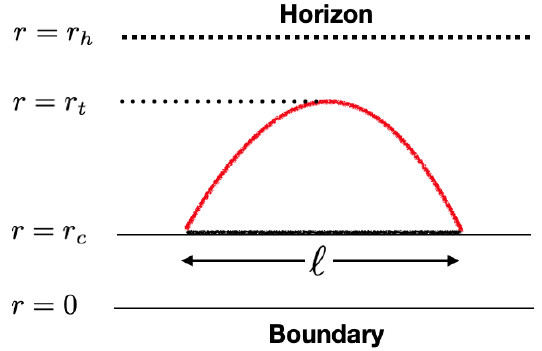
Figure 1 . A strip entangling region with the Ryu-Takayanagi surface (red). The strip has the length ‘ in the x -direction. The length in other directions is denoted as L := R d x 1 the cutoff, r the largest r value of the minimal surface in the bulk, and r t